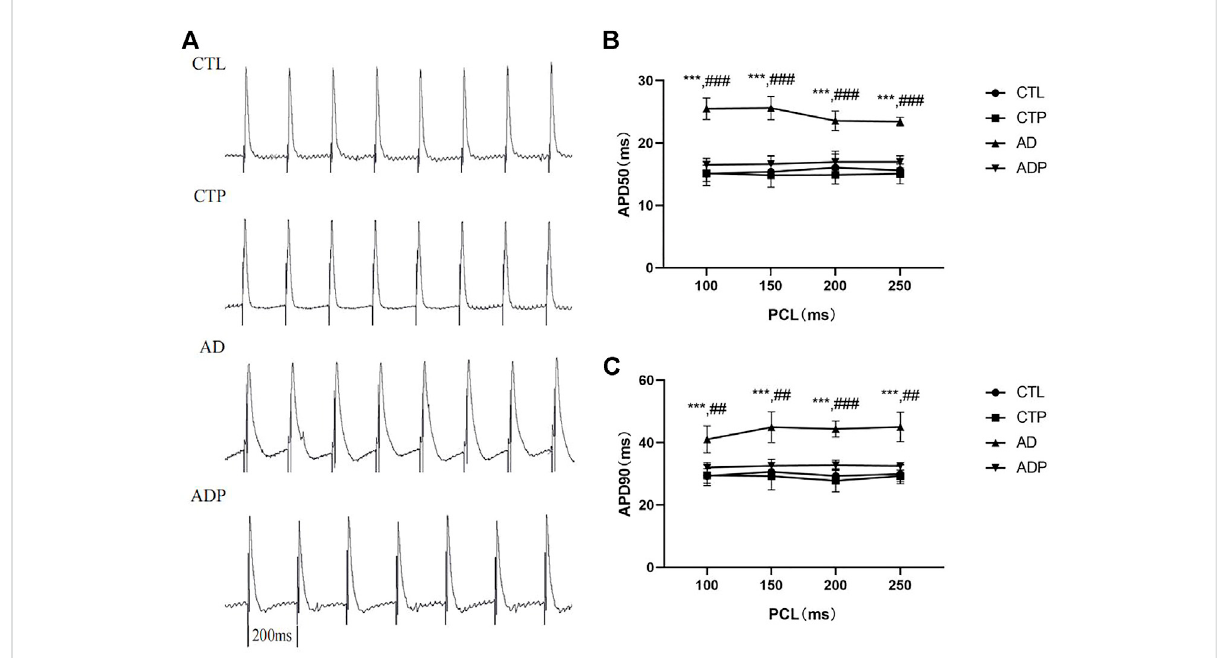
FIGURE 3 Action potential duration. (A) Typical recordings of APD at PCL of 200 ms. (B,C) The spatial dispersions of APD 50 and APD 90 at PCL of 250 ms, 200 ms, 150 ms, 100 ms. n = 7 per group. * p < 0.05, ** p < 0.01, *** p < 0.001 vs. CTL; # p < 0.05, ## p < 0.01, ### p < 0.001 vs. AD.